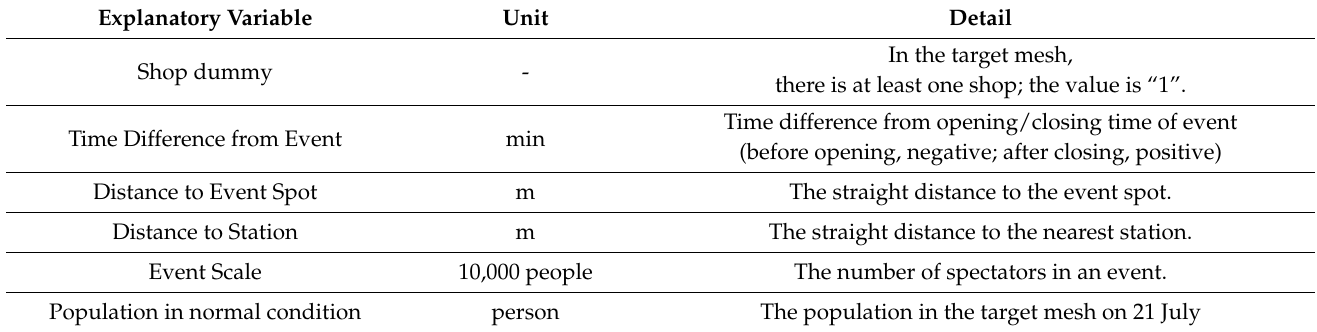
Table 3. Overview of explanatory